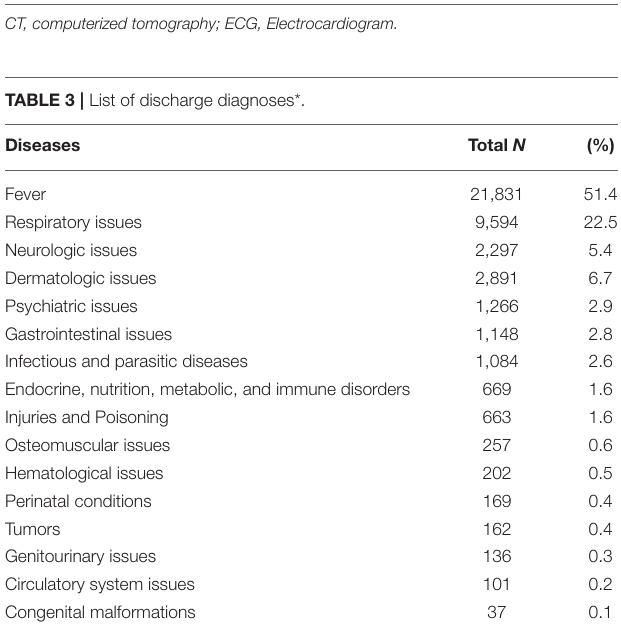
TABLE 3 | List of discharge